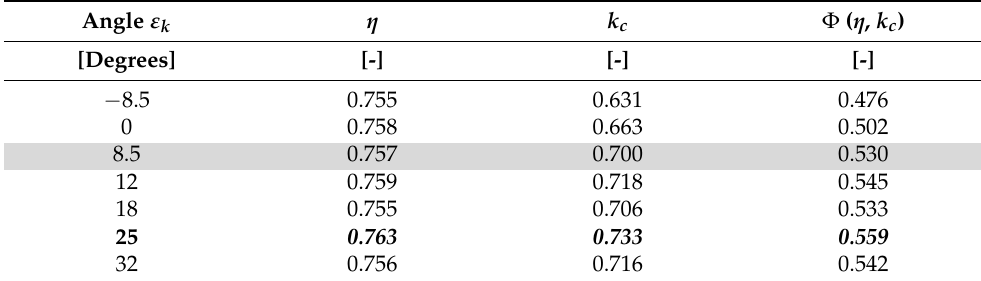
Table 11. The effect of the angle at the end of a return guide vane.